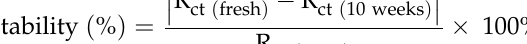
Figure 6. Storage stability of MIP-AF-modified SPEs at room temperature for 10 weeks.